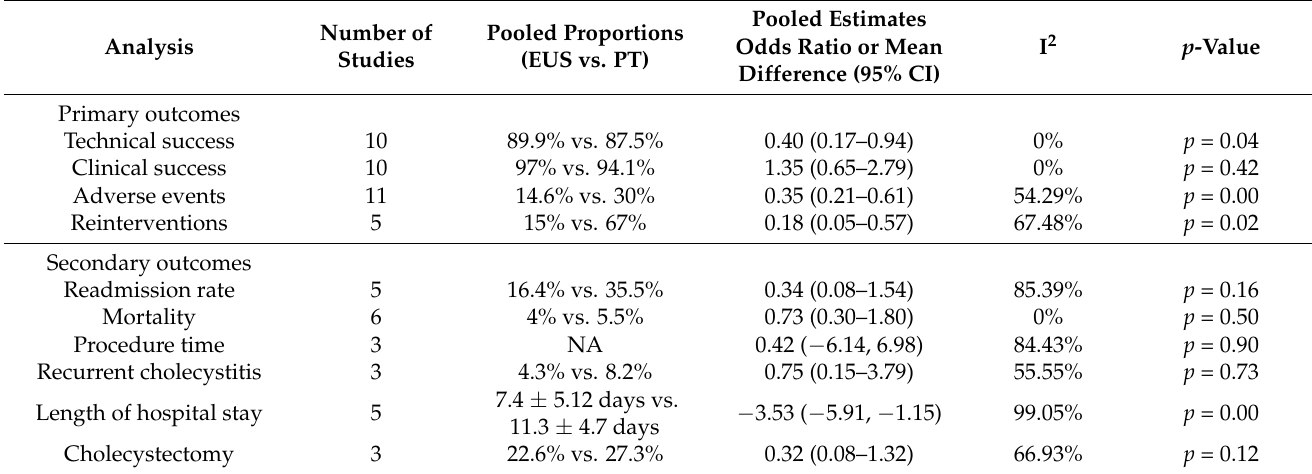
Table 3. Summary of findings from